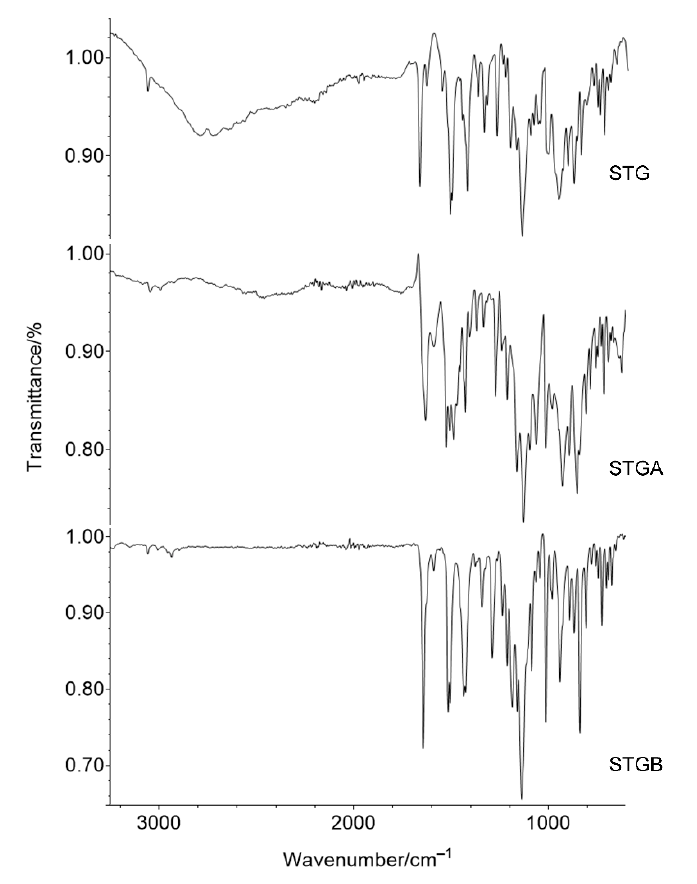
Figure 11. Comparison of Fourier transform infrared (FTIR) spectra for samples of sitagliptin phosphate monohydrate (STG), sitagliptin phosphate anhydrous (STGA) and sitagliptin base form (STGB).